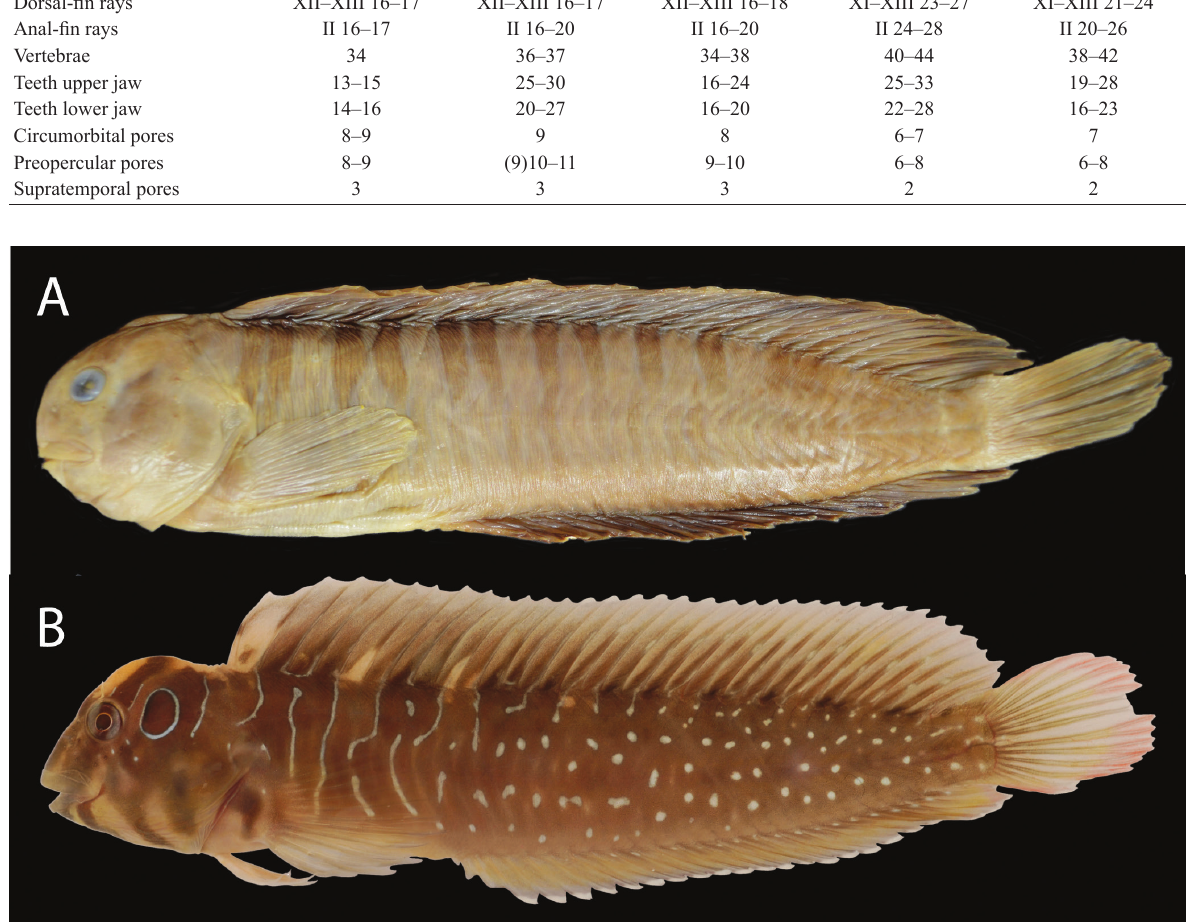
Figure 2. Lateral view of Salaria spp.: S. basilisca , MNHN-IC-A-1779, syntype, 138 mm SL, Italy: Mediterranean Sea at Genoa ( A ; photo credits: J. Pfliger); S. pavo , MNHN-IC-2012-0254, 74 mm SL, Balearic Islands at Menorca ( B ; photo credits: S.